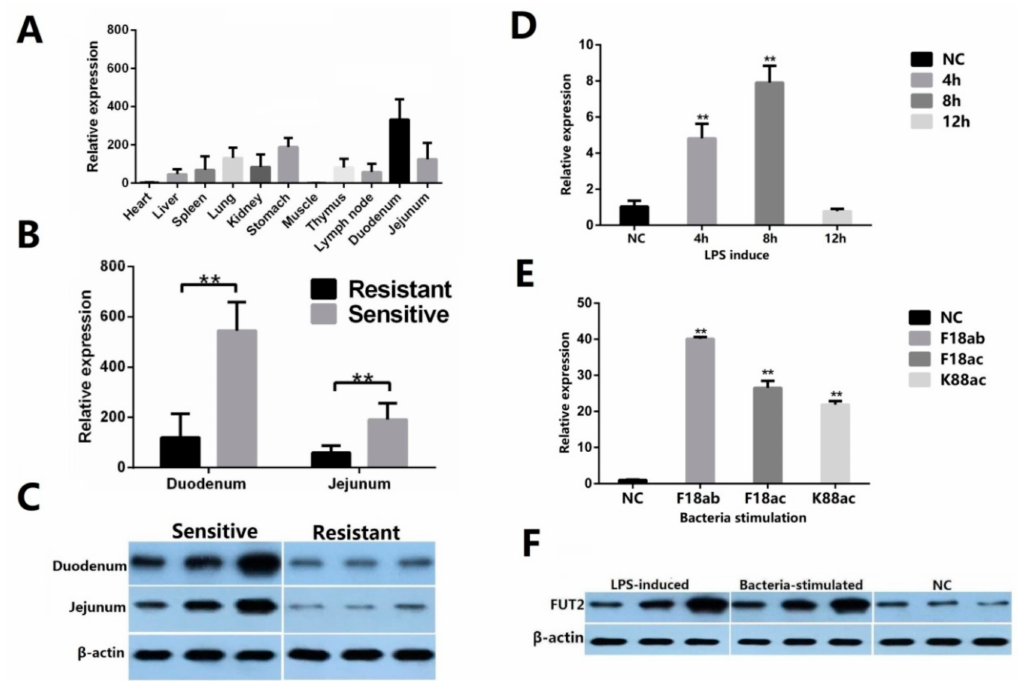
Figure 4. The association between FUT2 expression and the E. coli F18 infection. ( A ) mRNA expression profile in different tissues; data are shown as mean ± SD; ( B ) qRT-PCR analysis of differential expression in intestinal tissues between E. coli F18 resistant and sensitive piglets, data are shown as mean ± SD, n = 3 biological replicates, ** p < 0.01; ( C ) western blot analysis of differential expression in intestinal tissues between E. coli F18 resistant and sensitive piglets, n = 3 biological replicates, β -actin, internal reference; ( D – F ) Expression validation of important DEGs in IPEC-J2 cells after lipopolysaccharide (LPS)-induction and bacterial stimulation. IPEC-J2 cells were stimulated with 0.1 µ g/mL LPS or E. coli F18ab, E. coli F18ac, and E. coli K88ac; ( D , E ) qRT-PCR analysis, data are shown as mean ± SD, n = 3 biological replicates, ** p < 0.01, NC: negative control; ( F ) Western blot analysis. β -actin, internal reference; NC: negative control, LPS-induced represents the cells induced with 0.1 µ g/mL LPS for 4, 8, and 12 h, respectively; bacteria-stimulated represents the cells stimulated with E. coli F18ab, E. coli F18ac, and E. coli K88ac, respectively, n = 1 biological